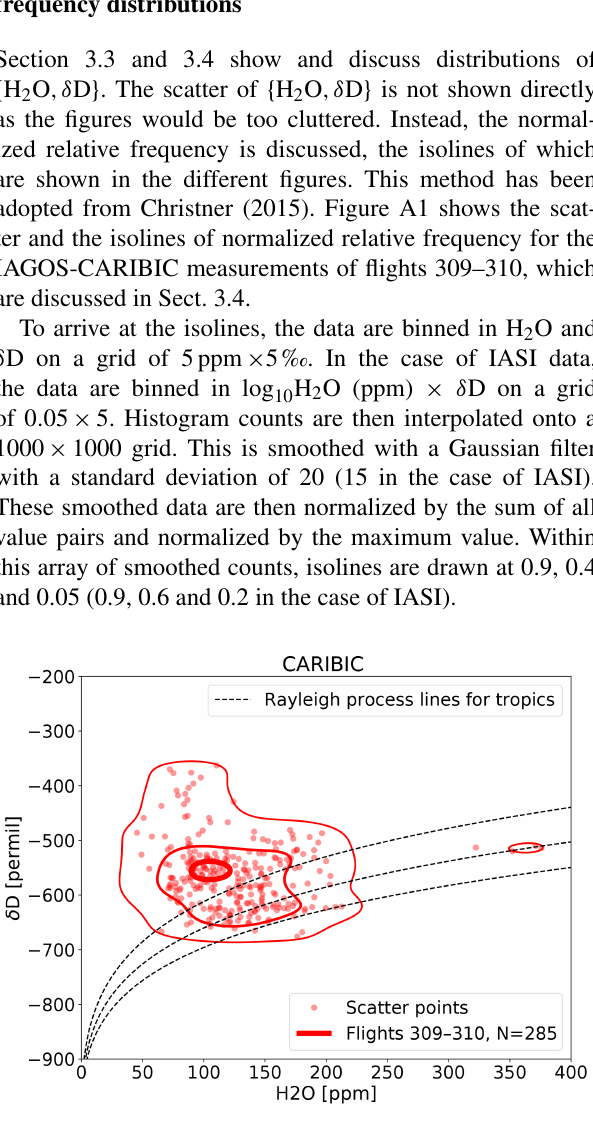
Figure A1. Scatter and isolines of the relative normalized frequency distribution for tropical (latitude ϕ < 30 ◦ N) measurements of δ D and H 2 O from IAGOS-CARIBIC flights 309 and 310 (September 2010). The figure demonstrates how the isolines (indicated at 0.1, 0.4 and 0.9) relate to the underlying